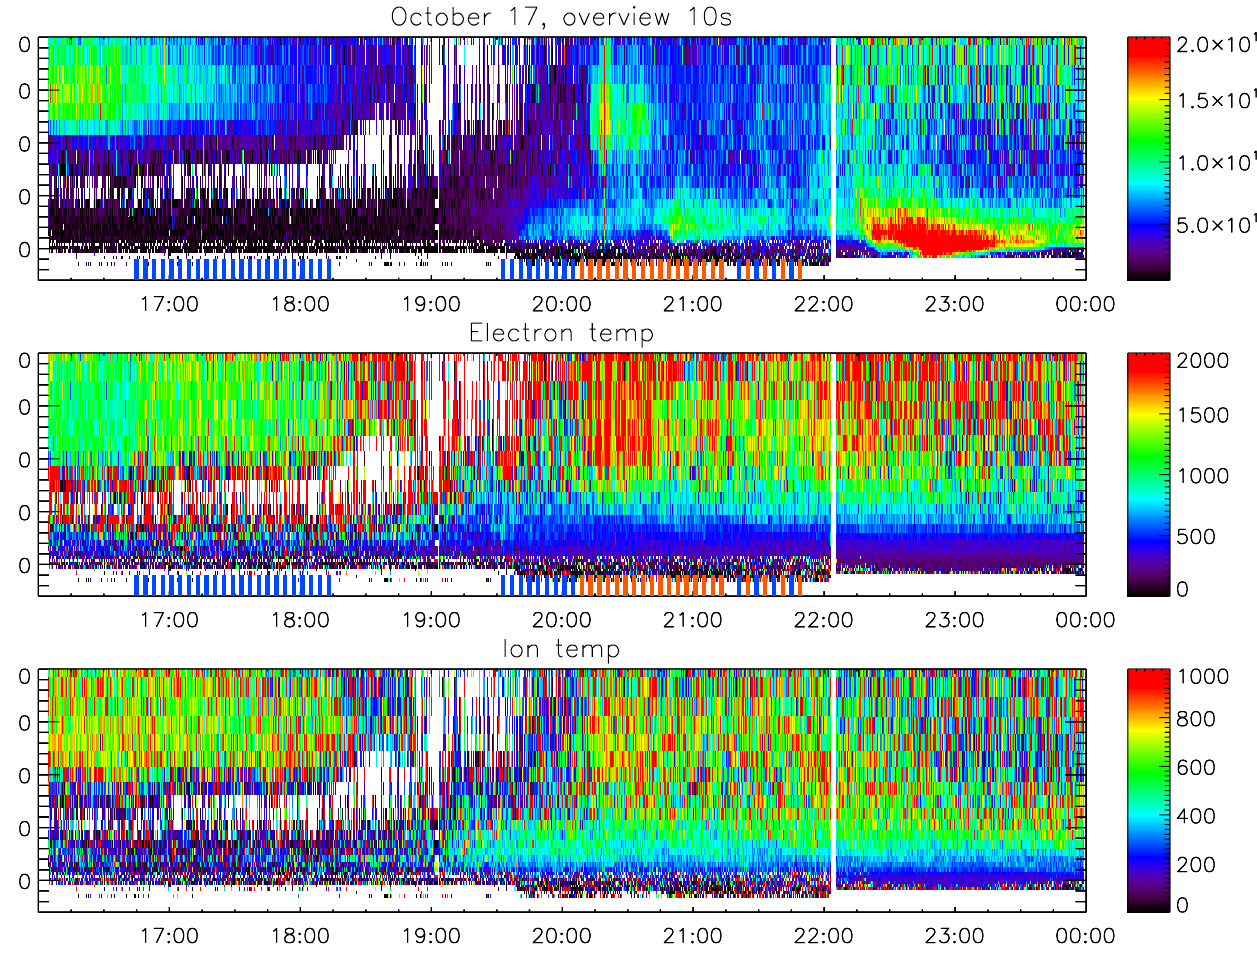
Fig. 1. Overview of the EISCAT data from 17 October 2008. Electron density (upper panel) shows a steady decrease until 19:00UT while T e (middle panel) is modulated by the HF-transmission, no significant change is seen in T i (lower panel). The bars under the plots indicate when the heater facility was running: blue bars indicate X-mode and red bars